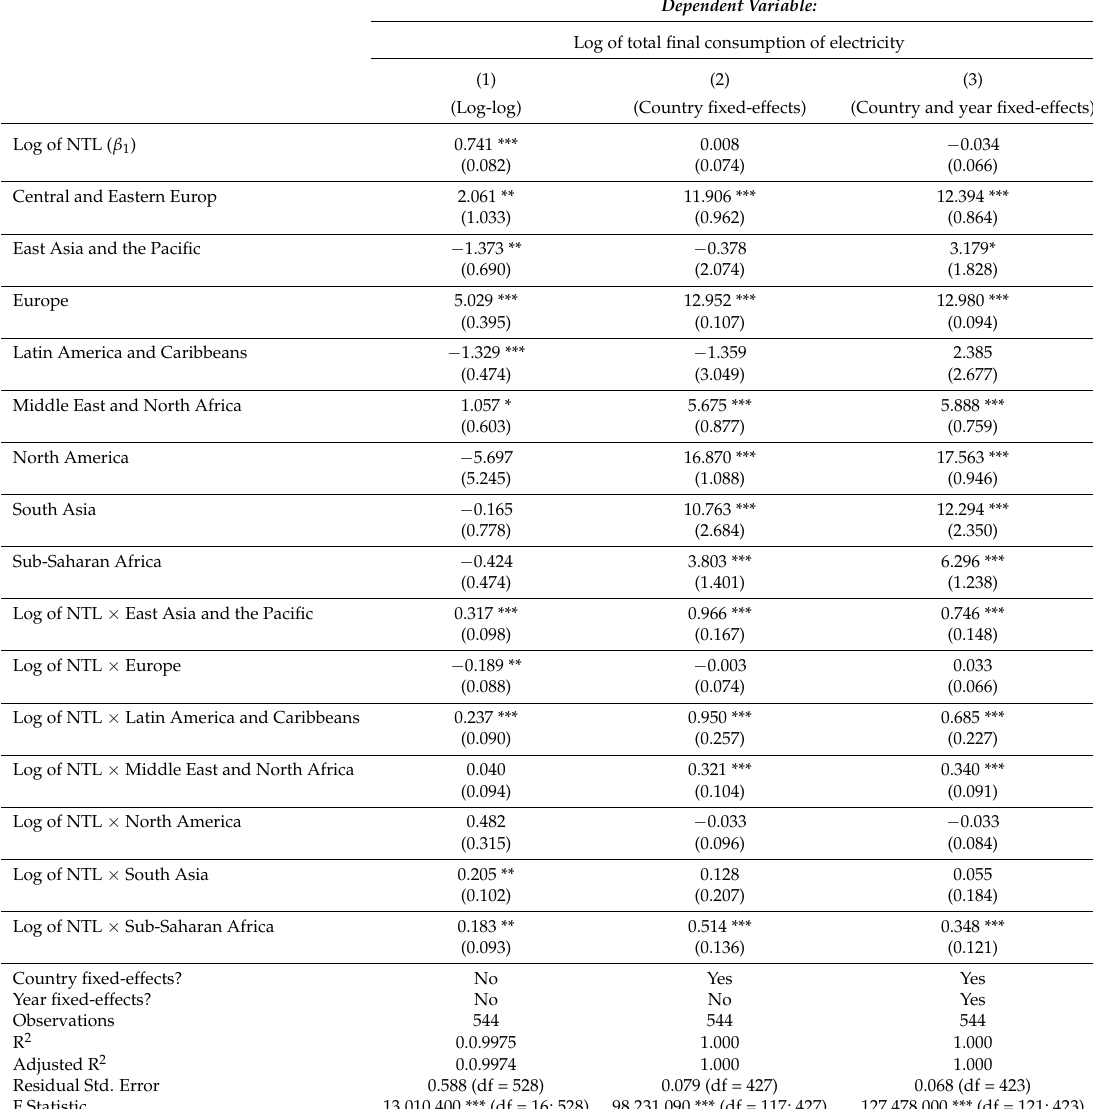
Table 7. Region clustering regression for